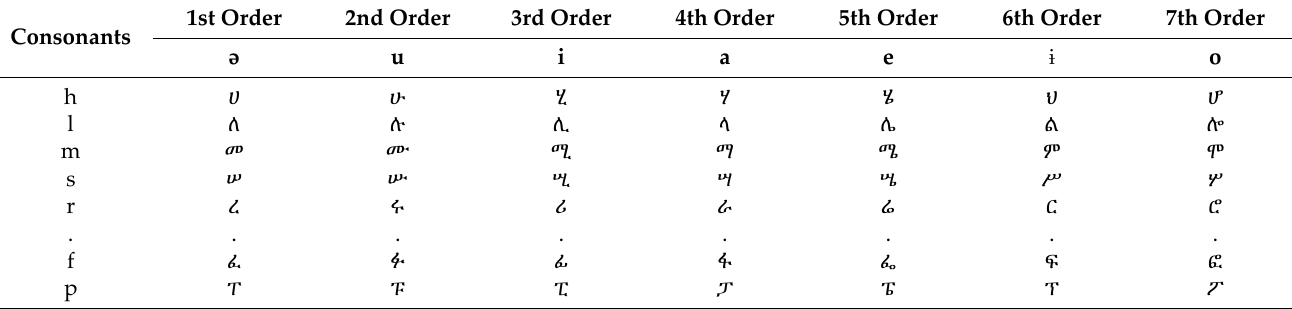
Table A1. Samples of Acmharic writing script/grapheme.